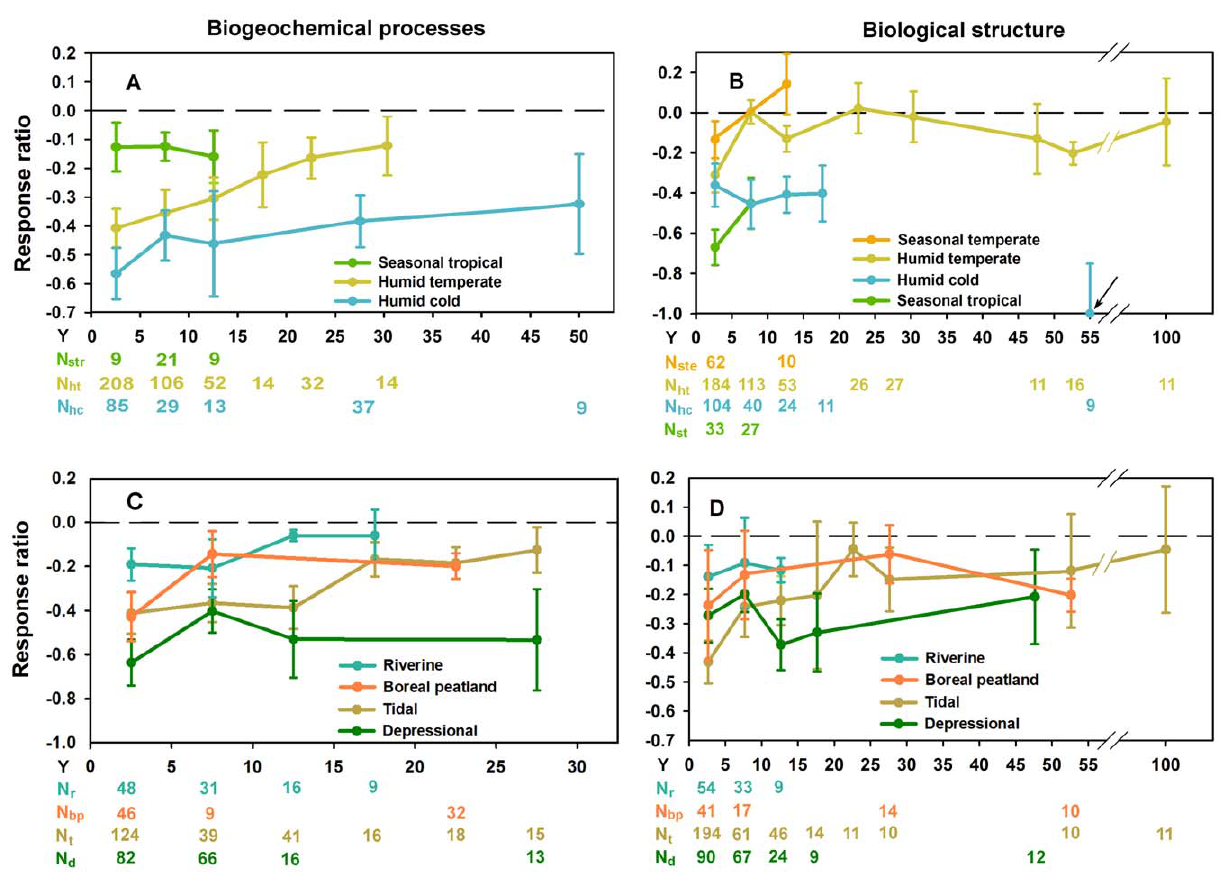
Figure 4. Effects of climate and hydrology on wetland recovery trajectories. Chronosequences of the means ( 6 standard error [SE]) of the response ratios (see Materials and Methods) of restored and created wetlands at successive age classes of 5 y or 10 consecutive y for biogeochemical functions and for biological structures under contrasting climates (A and B), and under different hydrologic connectivity (C and D) [31]. The zero value dashed line represents reference wetlands. The arrow (B) indicates the outlier mean value of two restoration studies with extremely low recovery rates (N, number of data points used to calculate the mean [ 6 SE] per age class; Y, years after restoration. Subscripts are as follows: bp, boreal peatland; d, depressional; hc, humid cold; ht, humid temperate; r, riverine; str, seasonal tropical; ste, seasonal temperate; t, tidal).